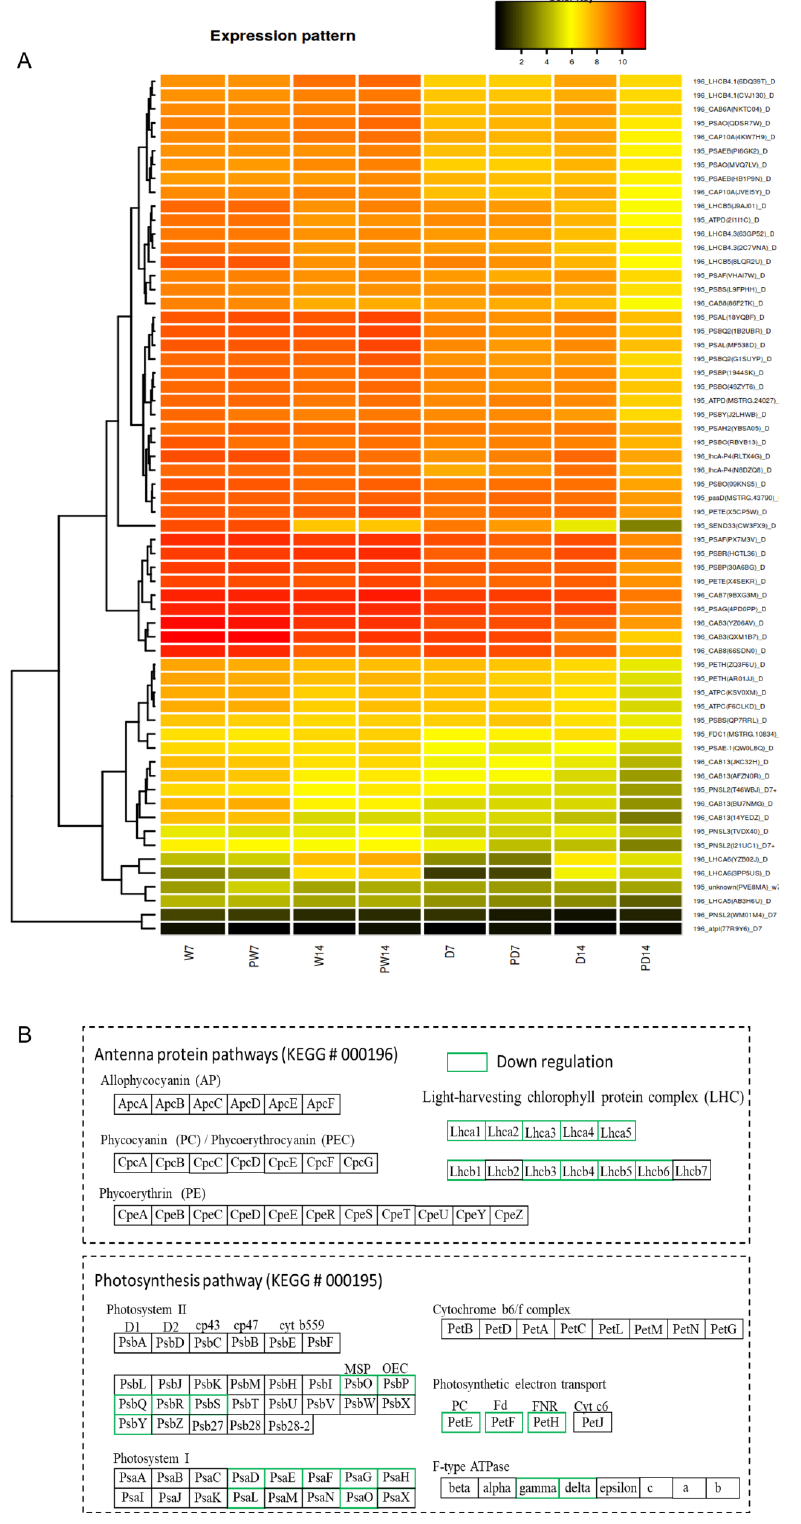
Figure 7. Comparison of DEGs in photosynthesis-associated pathways under well-watered and drought conditions. ( A ) The heatmap showing the transcript levels of differentially expressed